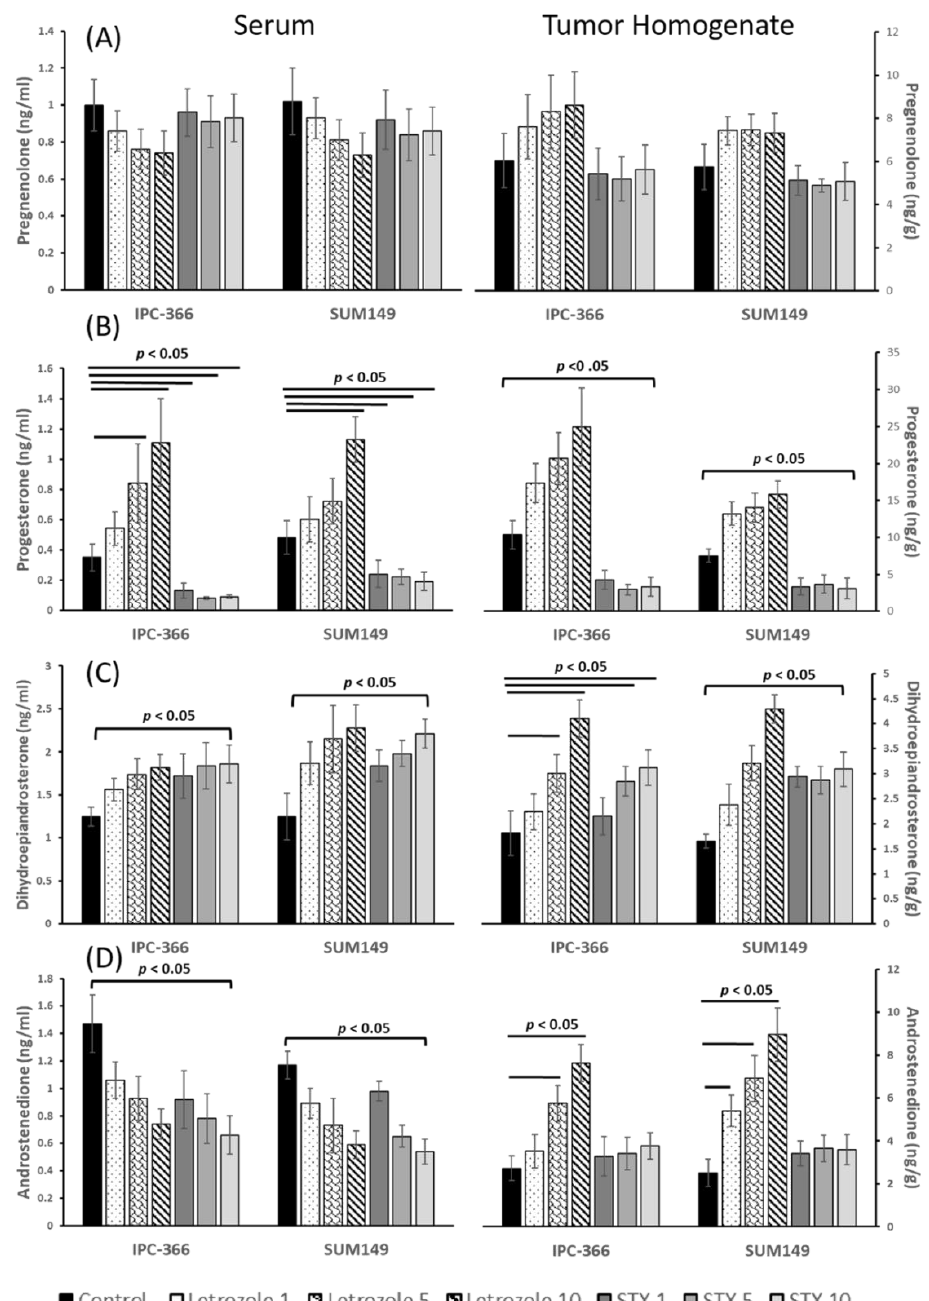
Figure 4. Steroid concentrations of ( A ) Pregnenolone (P5); ( B ) Progesterone (P4); ( C ) Dehydroepiandrosterone (DHEA) and ( D ) Androstenedione (A4), in serum and tumor homogenate samples of treated xenografts from IPC-366 and SUM149. Results showed an increased in DHEA concentrations on serum and tumor samples of xenografts treated with letrozole and STX-64. P4 levels increased in mice treated with all doses of letrozole and decreased in mice treated with STX-64. Bar represents means ± SD. significant differences between control and treated groups ( p < 0.05).